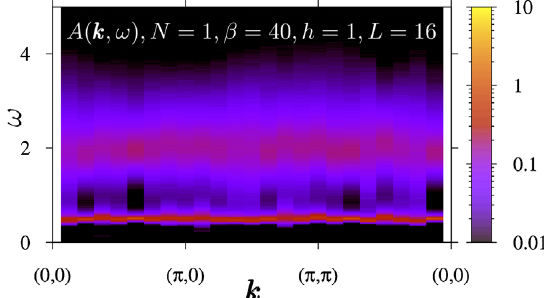
FIG. 3. Single-particle spectral function A ð k ; ω Þ for the N ¼ 1 model. As argued in the text, A ð k ; ω Þ is k